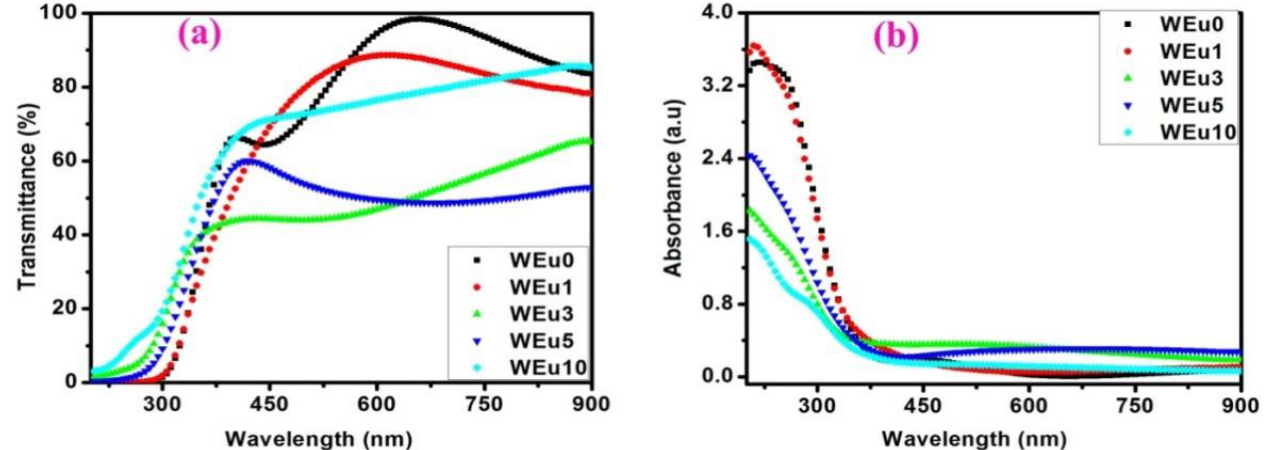
Figure 10. ( a , b ) Transmittance and absorbance spectra of the un-doped and Eu 3+ -embedded WO 3 films annealed at 600 °C.